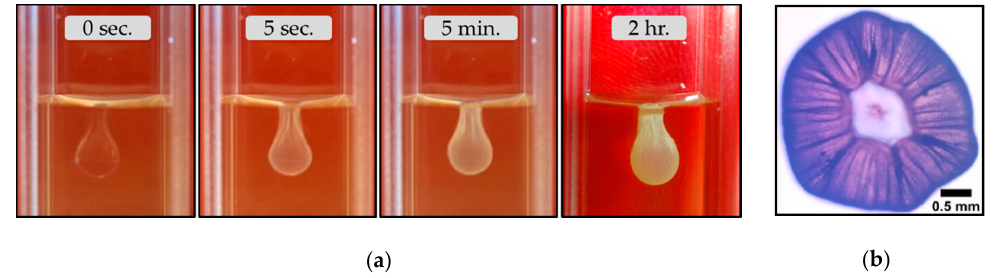
Figure 9. Mineral vesicles synthesized by adding manganese chloride on Magadi water. ( a ) Growth process of the vesicles (width of the cuvette is 1.25 cm); ( b ) hollow vesicle with its opening and corrugated surfaces.